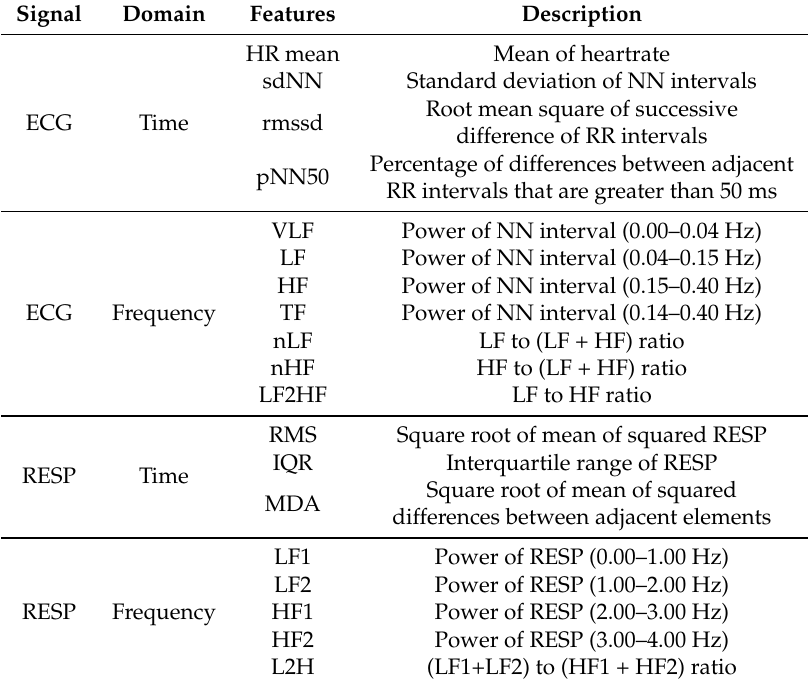
Table 1. A list of features extracted from ECG and RESP. We computed the power spectral density of ECG’s NN interval and RESP, using Welch’s method, to extract frequency domain